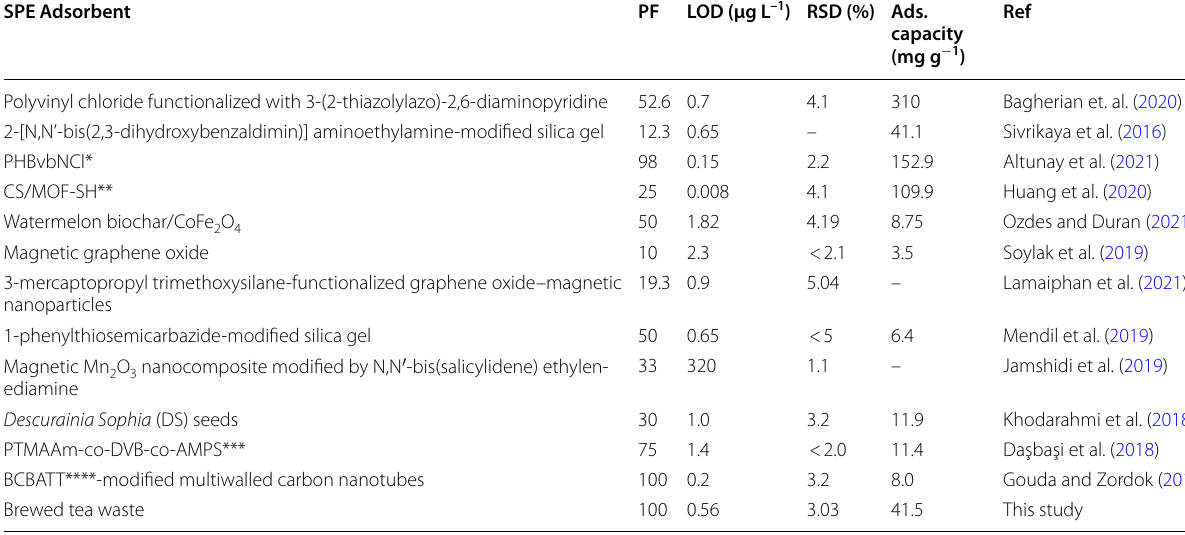
Table 5 Method performance comparison with other studies on SPE of Cd(II)